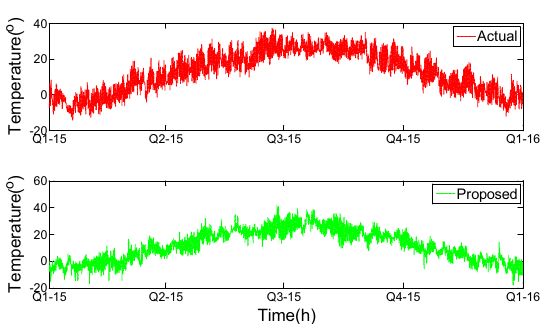
Fig. 3 Temperature values simulated based on the proposed model